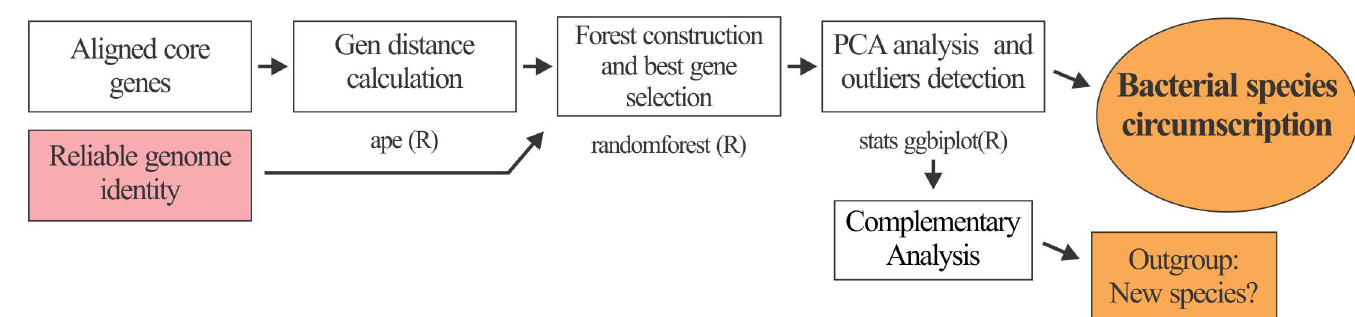
Fig 5. Pipeline to circumscribe bacteria as well as to rank genes base on their importance. First, gen distances among all individuallyalignedcore genes are calculated. Then, a forest of decisiontrees is constructed considering all variablesand as classes the suggestedspecies names that resulted from the genomic, phylogenomic and functional cluster analysis (pipeline describedin Fig 1). The importanceof the variablesare computed using RF algorithm [30]. Finally, distances of the most important gene are used to perform a PCA to circumscribe bacteria and identify outclasses. Further analysis (base on phylogenomic, genomic, and experimental phenotypic information) have to be performed to classify those outlier